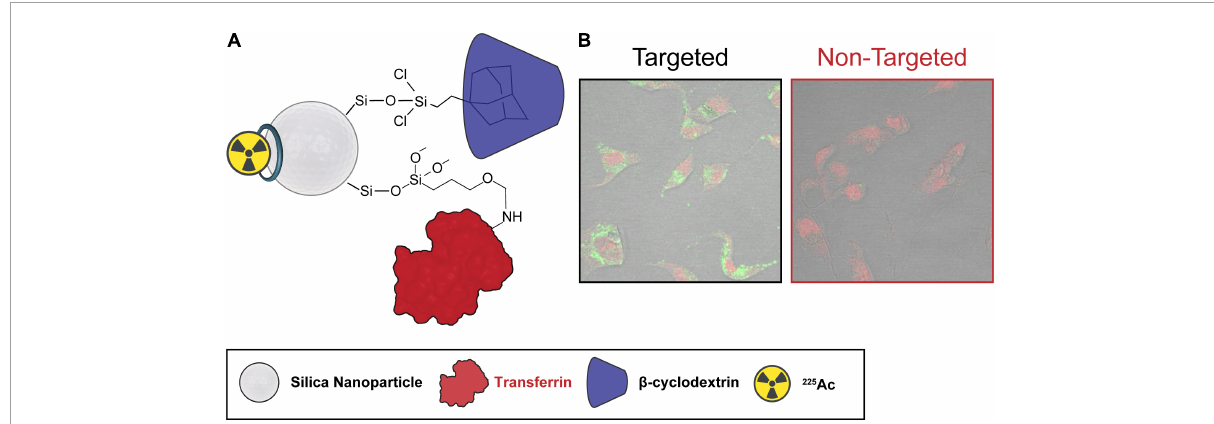
FIGURE5 Silica nanoparticles as delivery vehicles for targeted alpha therapy. Silica nanoparticles were used as delivery vehicles of 225 Ac for targeted alpha therapy. Transferrin and cyclodextrin were used as targeting and stabilizing agents, respectively. (A) Schematic representation, (B) cellular uptake with and without targeting agent. Adapted with permission from ref 139. Copyright 2020 American Chemical Society.